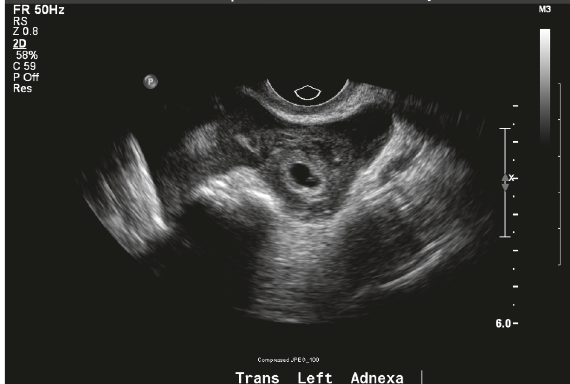
Figure 4: Right tubal ectopic pregnancy (treated with